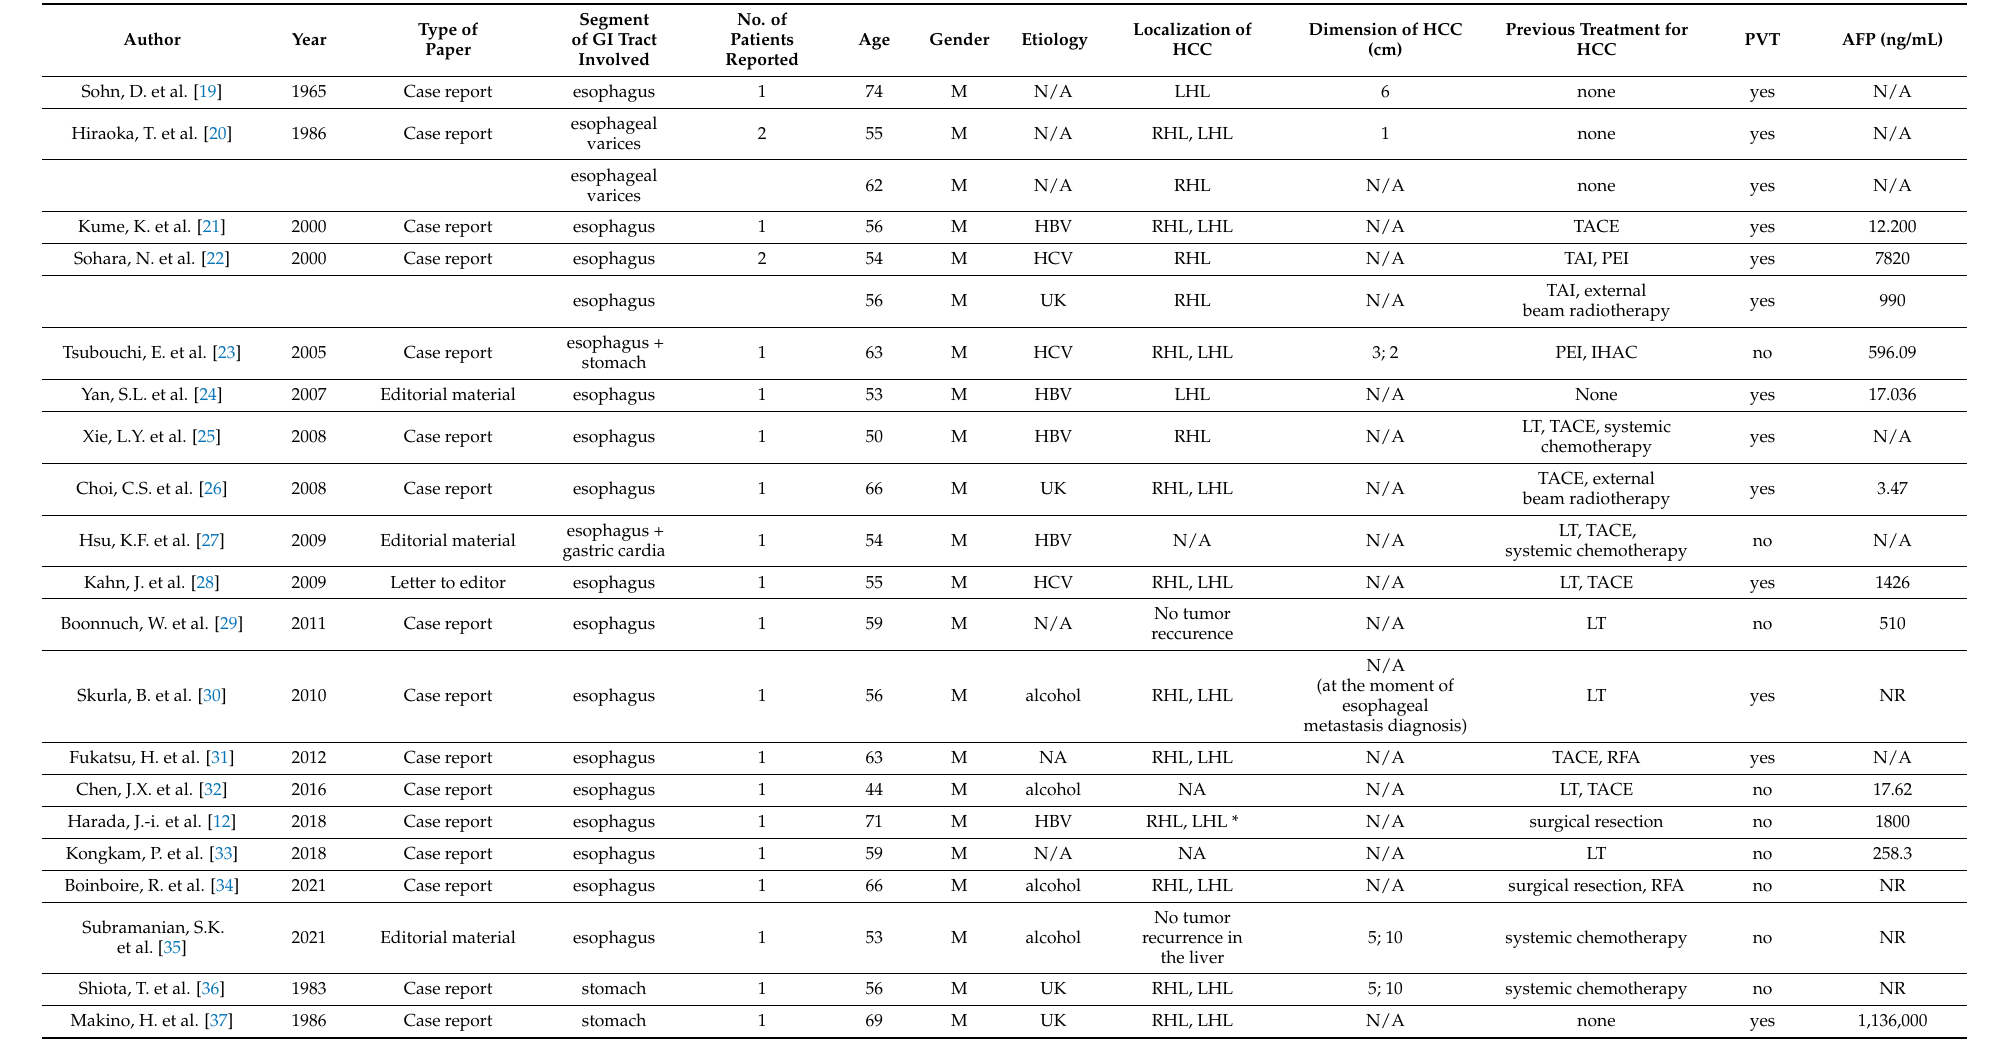
Table 1. Literature review of cases with gastrointestinal involvement from hepatocellular carcinoma—characteristics of HCC